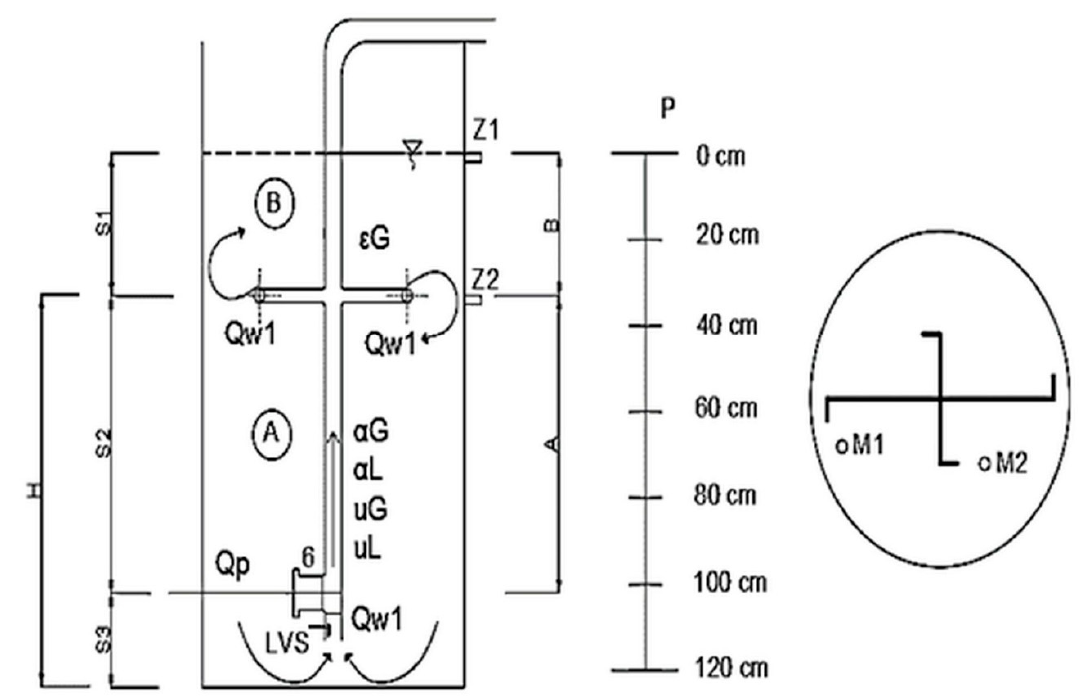
Figure 3. Diagram of hydraulic and technological tests: I—section, II—view from above, P—measurement level of LDO, Qp—supply air flow rate, Qw1—flow rate of water in the section 6-H, LVS—liquid velocity sensor of LVS, α G—gas holdup for ALR, α L—liquid holdup for ALR, ε G—gas